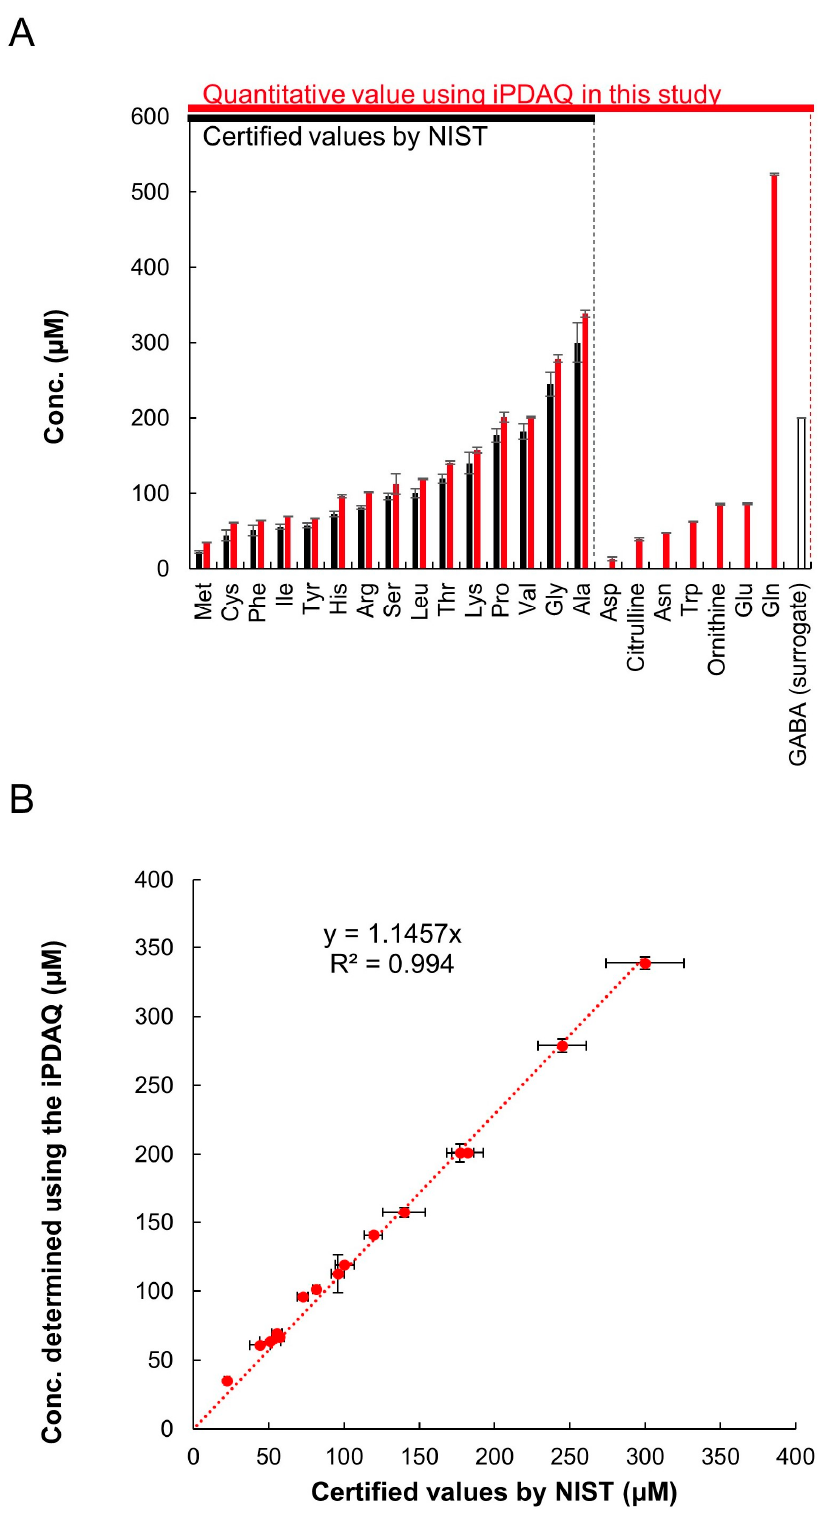
Figure 4. iPDAQ method validation using reference human plasma sample SRM1950. ( A ) Amino acid concentration in SRM1950. Black bars, certified amino acid concentrations provided by NIST. Red bars, amino acid concertation quantified using the iPDAQ method. Open bar, GABA used as a surrogate. ( B ) Comparison of the amino acid concentrations determined using the iPDAQ with the certified values provided by NIST. Error bars indicate the standard deviation ( n = 3).